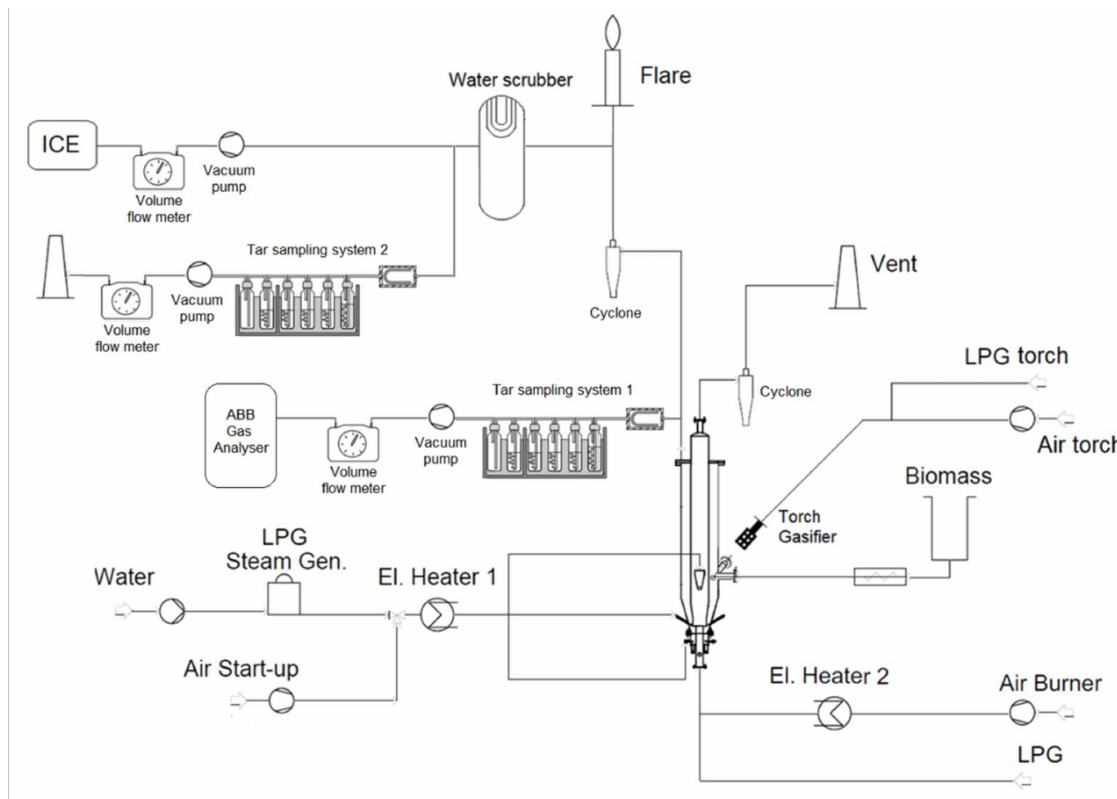
Figure 2. Flowsheet of the gasification pilot